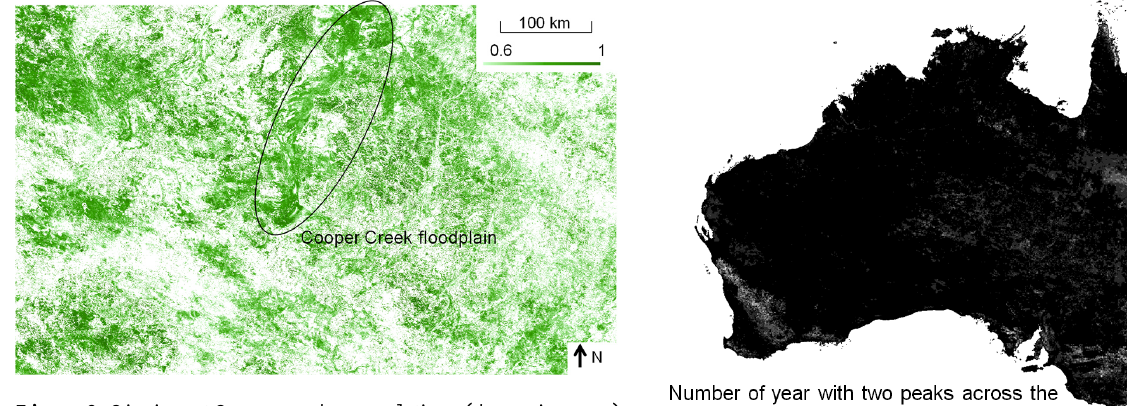
Figure 9. Significant Spearman rho correlations (shown in green) between monthly SOI and phenological cycle peak magnitude over a region in central Australia. The Cooper Creek floodplain of the middle reach of the Cooper Creek is visible in the center. Only areas with p < 0 . 05 and rho > = 0 . 6 are shown. Figure 10. Number of years within the 14-year time series where